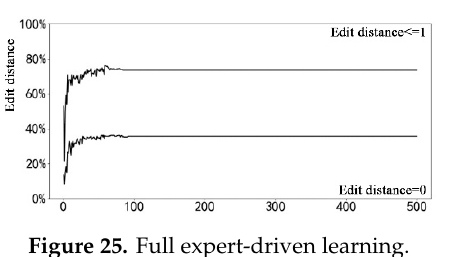
Figure 24. Expert-driven learning with a factor of ½.